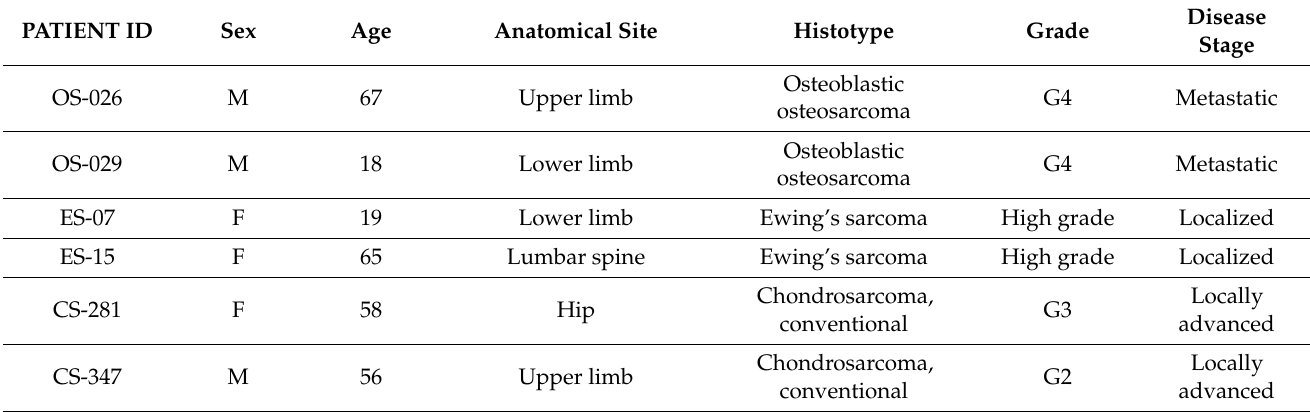
Table 1. Patients’ characteristics, tumor anatomical site, histotype and tumor grade and disease stage of the primary tumors that were analyzed and from which PDXs were